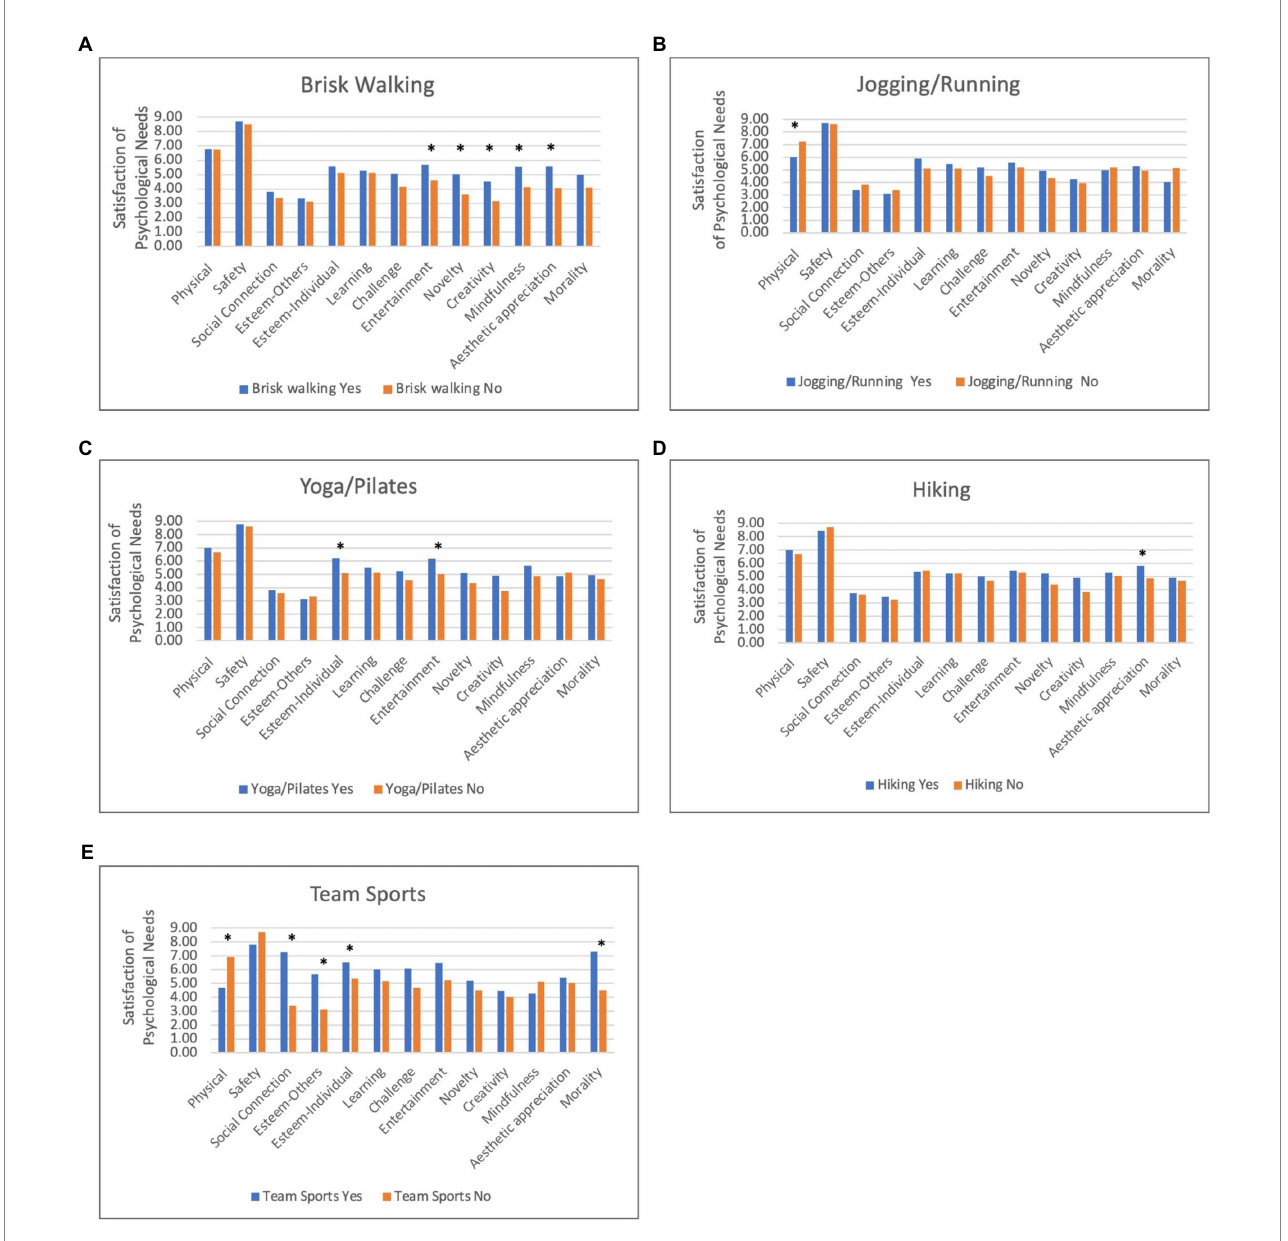
FIGURE 1 Differences in related psychological need satisfaction by past 7-day engagement (yes vs. no) in different types of physical activity: (A) Brisk Walking; (B) Jogging/Running; (C) Yoga/Pilates; (D) Hiking; and (E) Team Sports. * p <